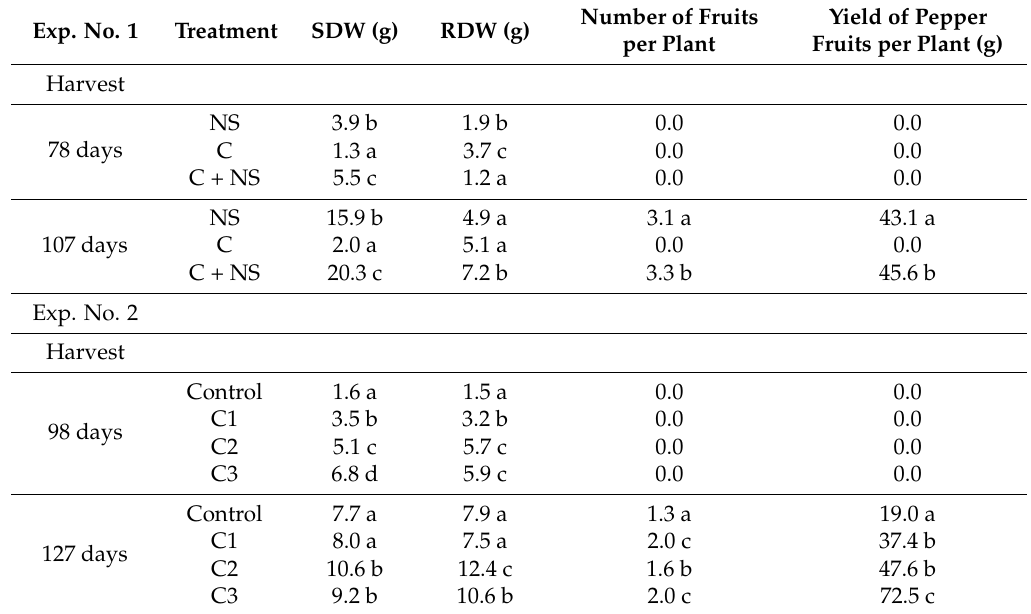
Table 2. Growth parameters in pepper plants and fruits after culture in the absence and the presence of AL compost. Exp. No. 1: NS, plants grown with full nutrient solution; C, plants only grown with compost; C + NS, plants grown with compost and complemented with full nutrient solution. Exp. No. 2: Control, plants grown with full nutrient solution; C1, C2, and C3, plants grown with